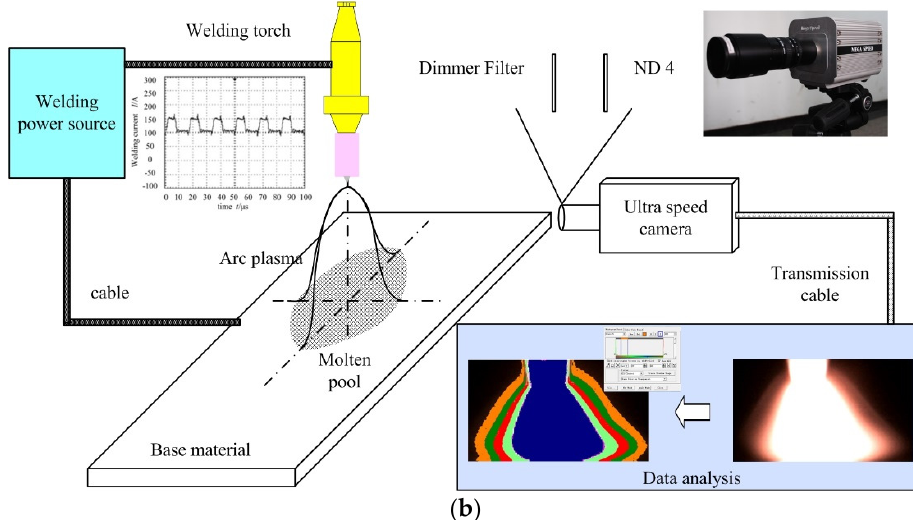
Figure 1. Visual inspection system for gas tungsten arc welding (GTAW): ( a ) simplified model; ( b ) physical model.